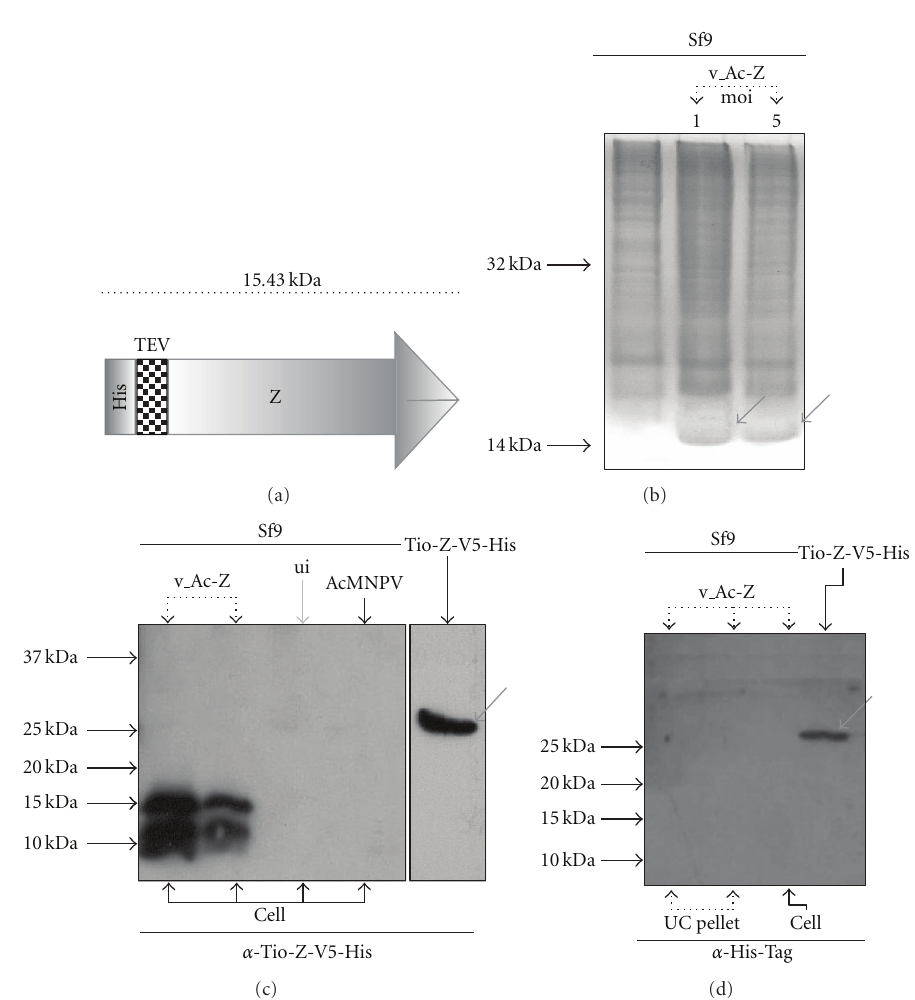
Figure 4: Z Protein Expression in Sf9 Insect Cell Line. (a) Diagram of the recombinant His-Z protein expressed on Sf9 Insect cell line. The white region represents the His-tag; the squared block indicates the specific protease TEV (GluAsnLeuTyrPheGln ↓ Gly) target sequence; and the gray arrow shows the Z protein. The molecular weight of the complete recombinant protein is 14 kDa, the cleavage products being 11kDa (Z) and 3 kDa (His-TEV). (b) 16% SDS-PAGE of Sf9 cells infected with v Ac-Z. Lane 1 shows the Sf9 cells without infection. Lanes 2 and 3 correspond to the Sf9 cells infected with v Ac-Z at di ff erent moi’s (1 and 5 resp.) after an incubation of 36 h. The arrows have shown the possible Z protein expression. (c) Western blotting with α -Tio-Z-V5-His. Total protein extracts from Sf9 cells infected with v Ac-Z (recombinant AcMNPV expressing Jun ´ ın Z protein; lanes 1 and 2 ) and AcMNPV (wild type baculovirus; lane 4) were loaded in the indicated lanes. Lane 3 corresponds to the control of uninfected cells (ui). Tio-Z-V5-His purified sample was used as a positive control (indicated with a red arrow). (d) Western blotting with α -His Tag polyclonal serum (Santa Cruz Biotechnology). Ultracentrifugated supernatant and cellular extract of Sf9 cells infected with recombinant v Ac-Z was loaded in the indicated lanes. At the bottom of each lane the origin of the sample is shown; Cell: Sf9 protein extract, UC pellet: ultracentrifugation pellet. Tio-Z-V5-His positive control is indicated with a red